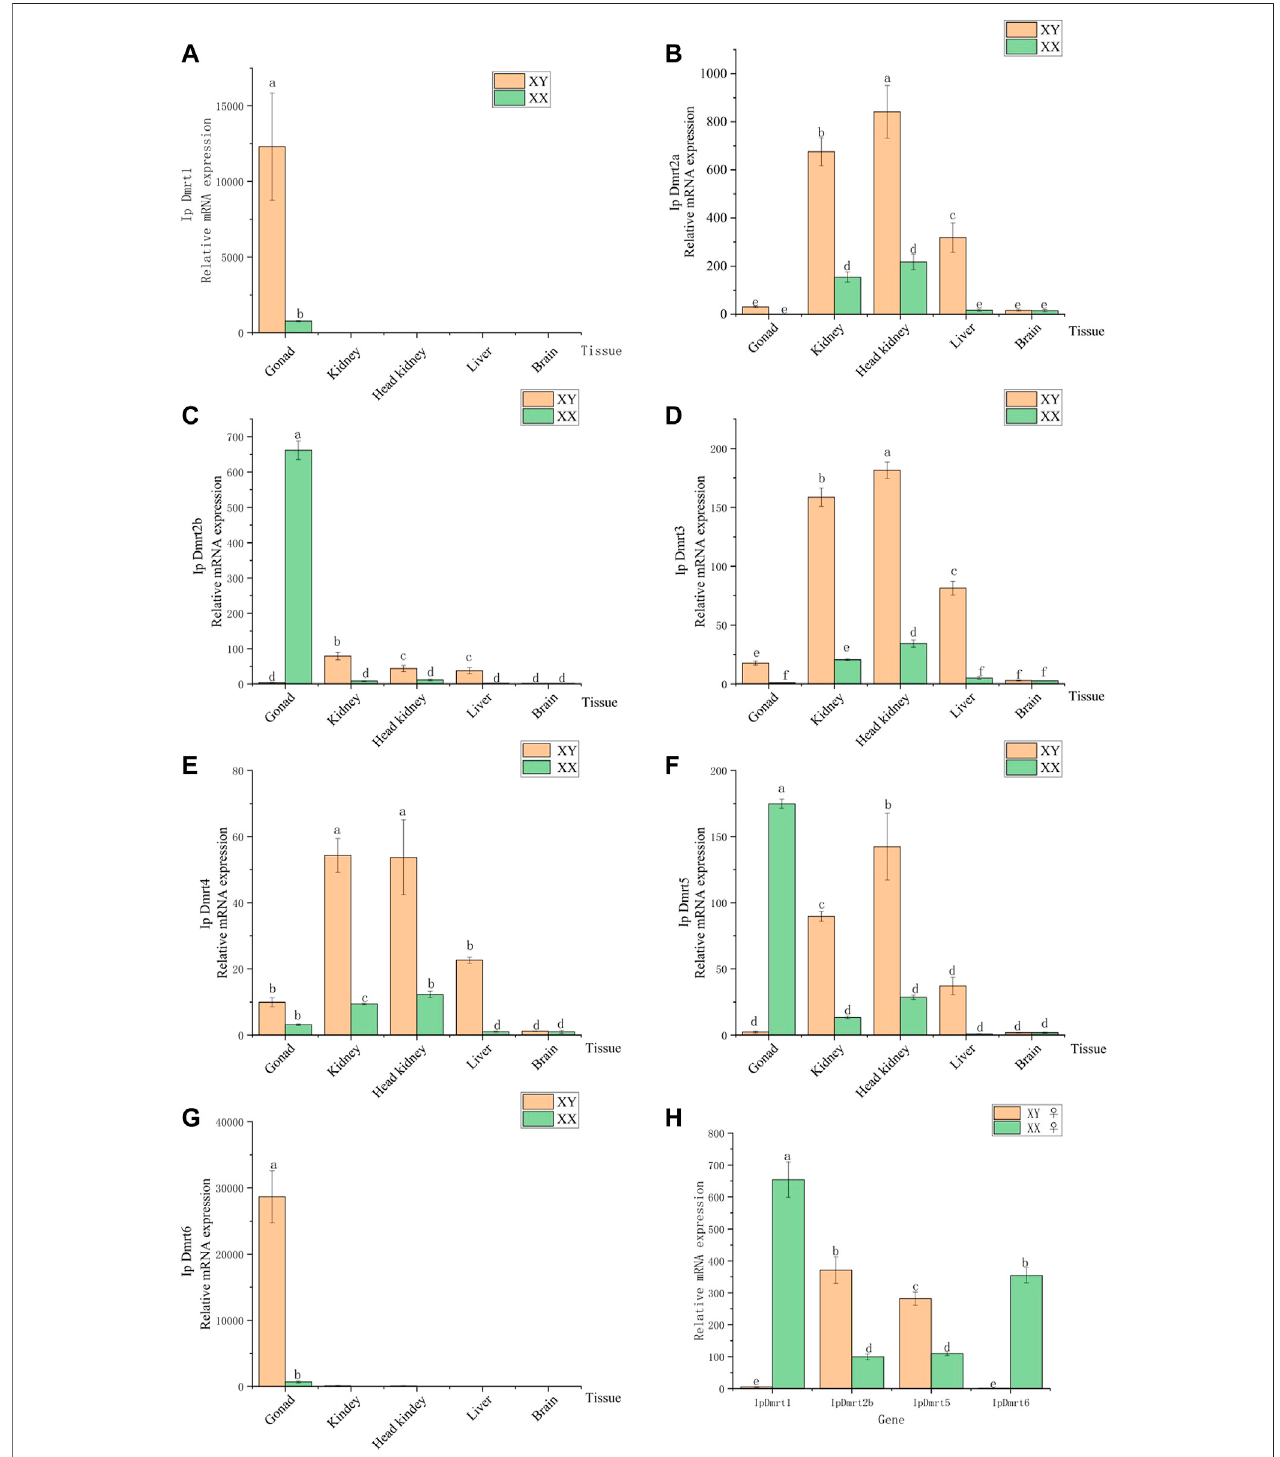
FIGURE 6 | Results of the qRT-PCR assay for channel cat fi sh Dmrt genes in testes and ovaries. The gene expression level was normalized to the α -tubulin transcript. Images (A) , (B) , (C) , (D) , (E) , (F) , and (G) , show the Dmrt genes expression level in gonad, kidney, head kidney, liver, and brain. Images (H) show the Dmrt1 , Dmrt2b , Dmrt5 and Dmrt6 genesexpressionlevelingonadwhicharefemale(XX)andfemale(XY).Ineachimage,differentlettersrepresentsigni fi cantdifferencesamong lines ( p < 0.05).